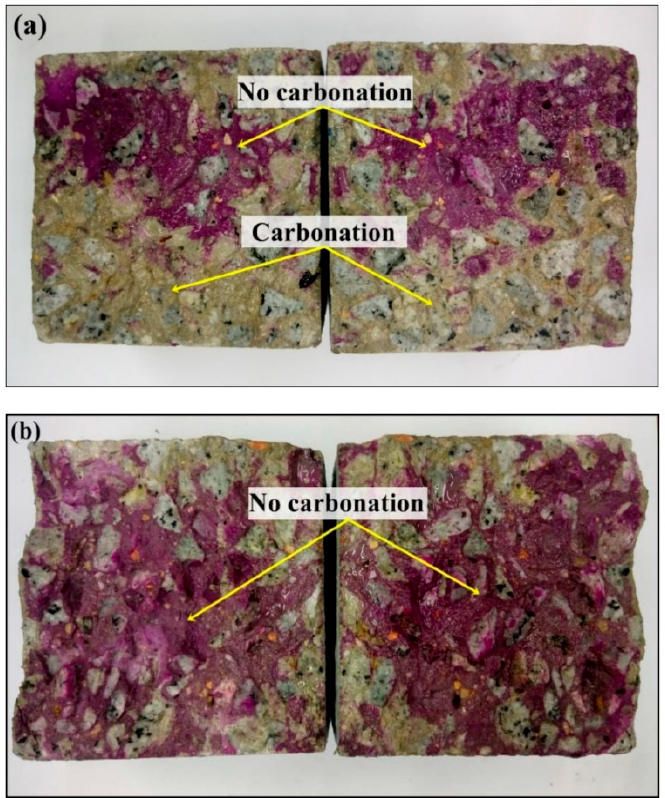
Figure 12. Expedited carbonation for concrete samples: ( a ) regulated and ( b ) GA-NP inhibitor. Reprinted with permission from Ref. [83]. MDPI 2021.